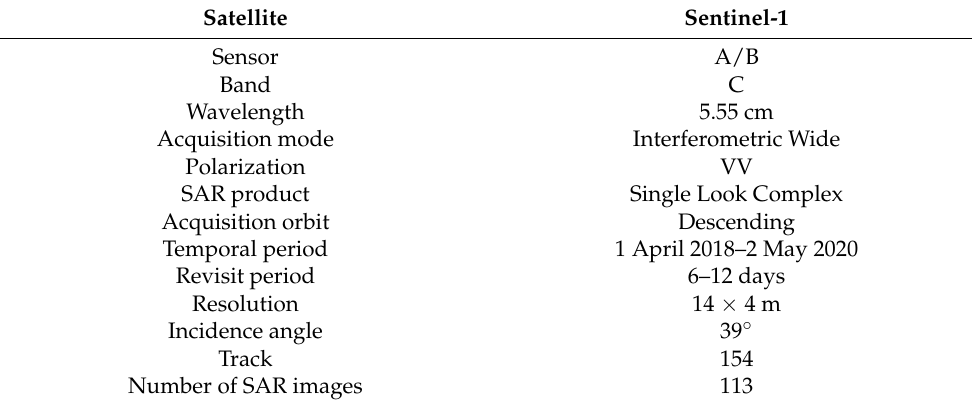
Table 2. Main acquisition parameters of the SAR satellite dataset